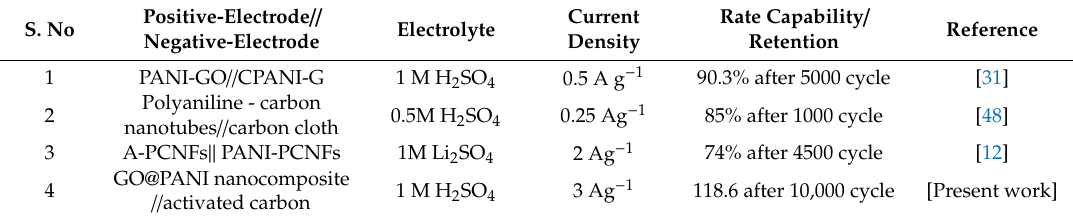
Table 2. Comparison of cycling stability of present device with previously reported asymmetric devices.